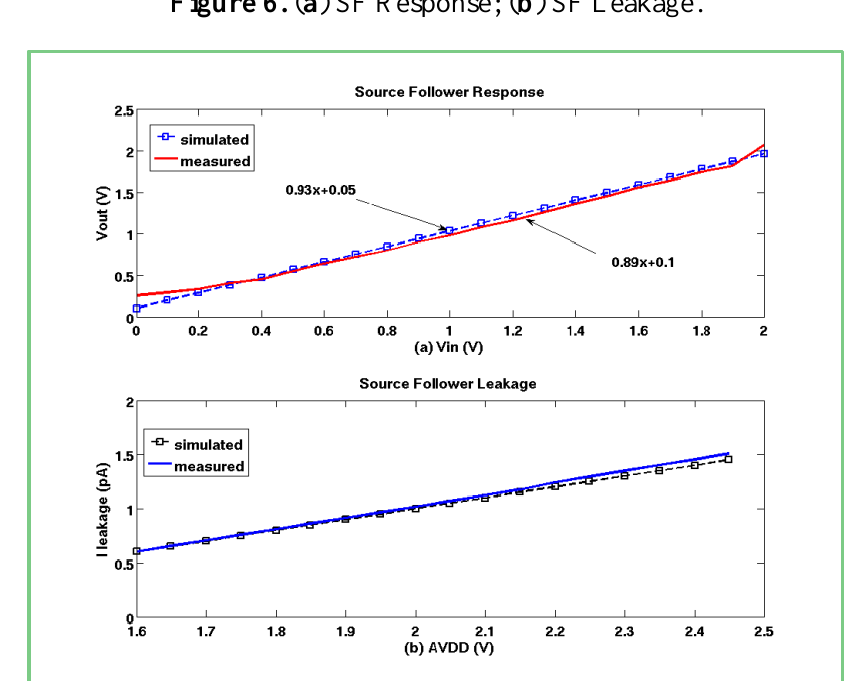
Figure 6. ( a ) SF Response; ( b ) SF